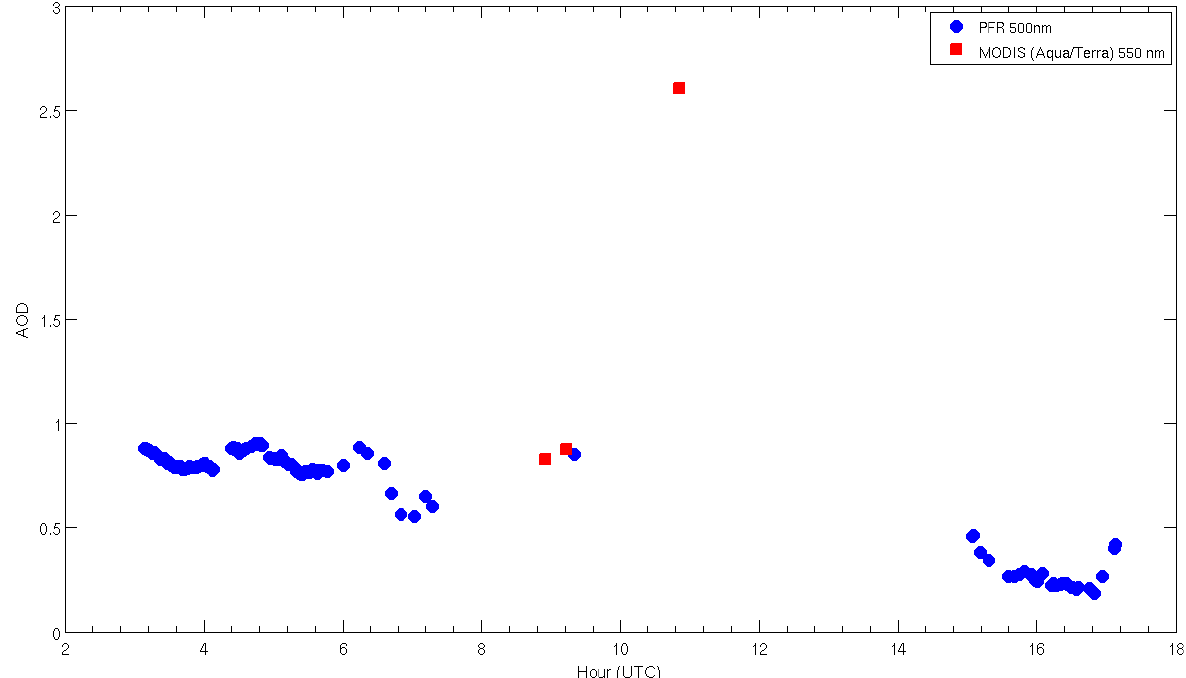
Figure 6. AOD values measured in Sodankylä with PFR (500 nm), and MODIS (550 nm) on 30 July